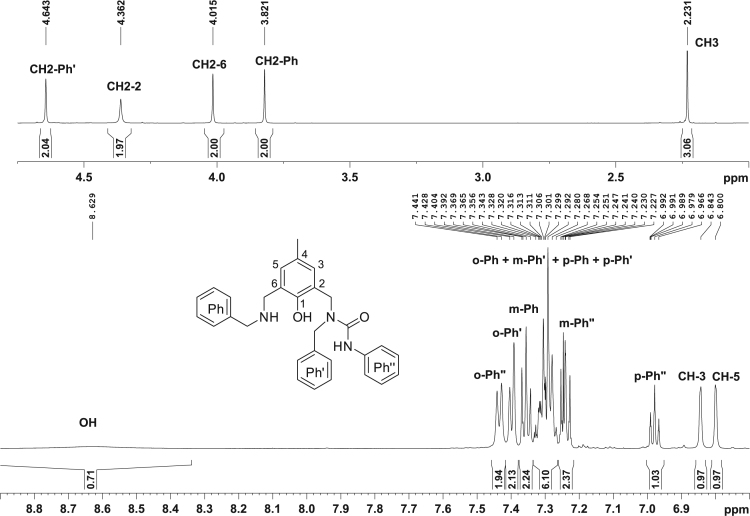
1H NMR spectrum of ligand S1.